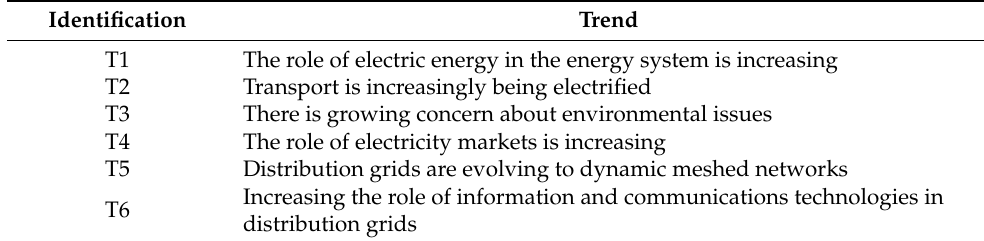
Table 1. Trends identified by experts in this